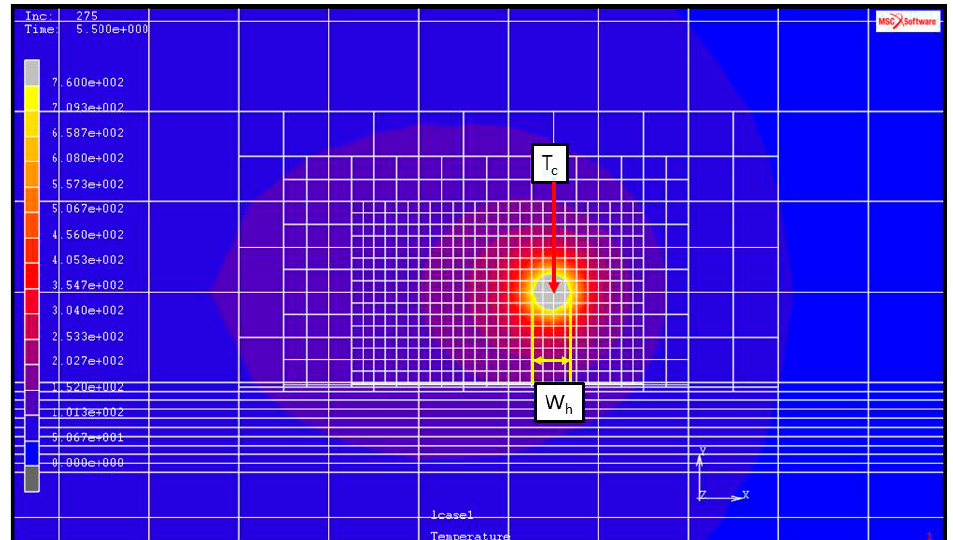
Figure 5. Example of the hardening width ( W h ) and maximum spot temperature ( T c ) caused by the application of a laser heat source. Materials 2018 , 11 , x FOR PEER REVIEW 8 of 21